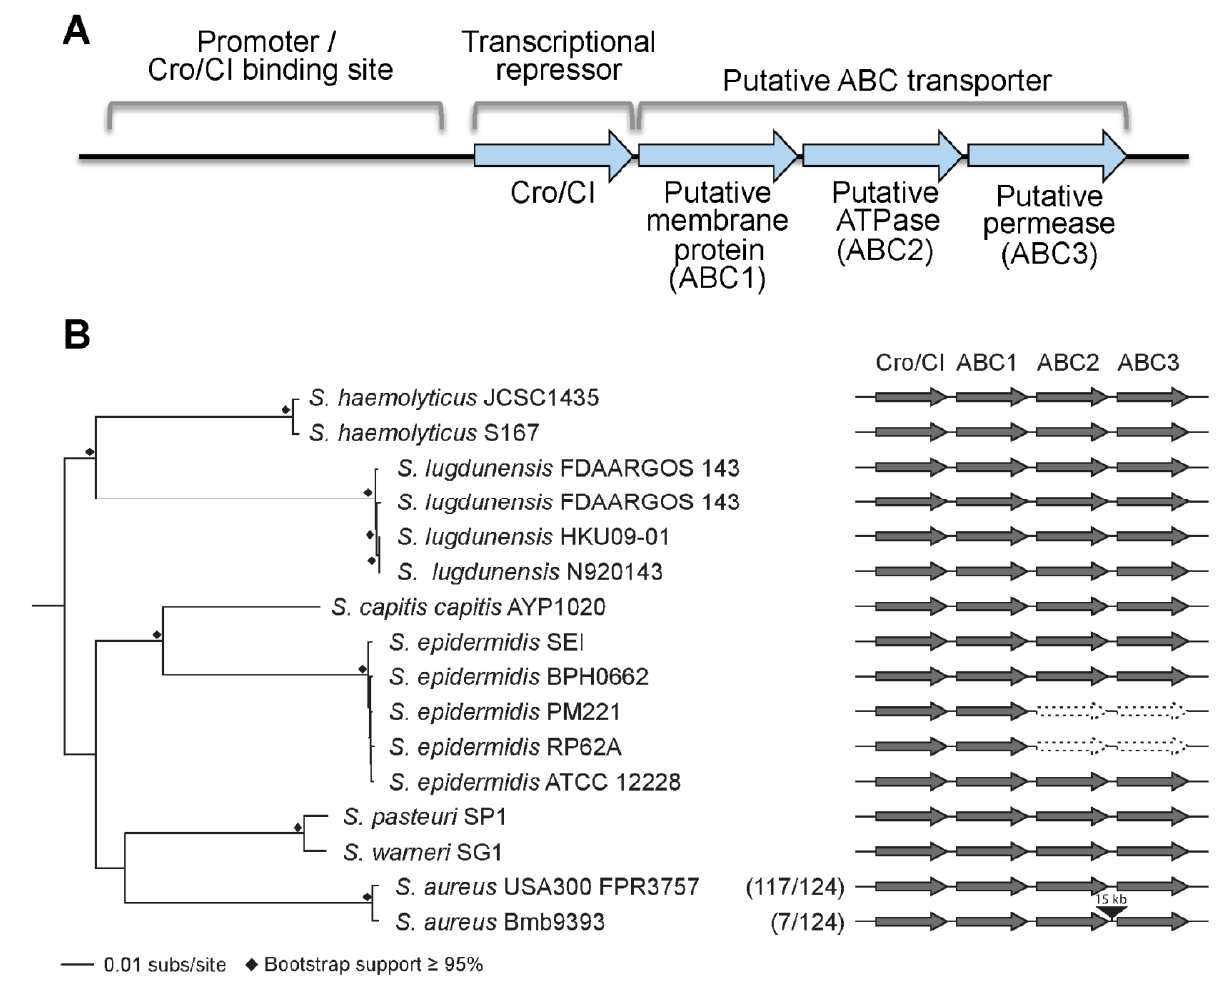
FIGURE 1: Genomic organization of the operon of the Cro/CI and ABC transporter operon in Staphylococcus . (A) Functional model for the operon in S. aureus . The S. aureus cro/cI gene is a homolog of the lambda phage transcriptional repressor cro , and shares an operon with three genes encoding a putative ABC transporter (abbreviated as ABC1, ABC2, and ABC3). S. aureus Cro/CI functions as a transcriptional regulator, suppressing transcription of all four operon genes. The putative binding site of the Cro/CI protein presumably lies just upstream of the cro/cI gene in its promoter area. Mutations in cro/cI lead to 40~100 fold over-expression of the putative ABC transporter, causing resistance to arylomycin derivatives. Genes and promoter area are not drawn to scale. For more details see reference [3]. (B) Schematic showing the genomic organization of the cro / cI - ABC transporter operon in selected pathogenic Staphylococcus genomes. The intact oper- on is well conserved in these staphylococci. Exceptions are the lack of ABC2 and ABC3 encoding genes in 2 of 5 S. epidermidis genomes, and an ~15 kb insertion between ABC2 and ABC3 in 7 of 124 S. aureus genomes. The phyletic distribution of cro / cI and the ABC transporter genes was determined using BLAST+ [8]. The maximum-likelihood (RAxML [9], GTRGAMMA) phylogeny was constructed on the basis of a concatenated core genome alignment generated using Mugsy [10]. Nodes with ≥ 95% bootstrap support from 1,000 replicates are indicated by black diamonds. Present genes are dark gray, absent genes are white with a dotted outline, and the insertion is black. In parentheses are the numbers of S. aureus strains of the total examined that share the genomic organization of the representative strains OPEN ACCESS | www.microbialcell.com